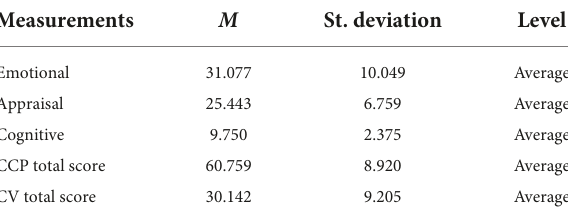
TABLE 3 Means, standard deviation, and levels of the CCP and CV of the sample study scores. Measurements